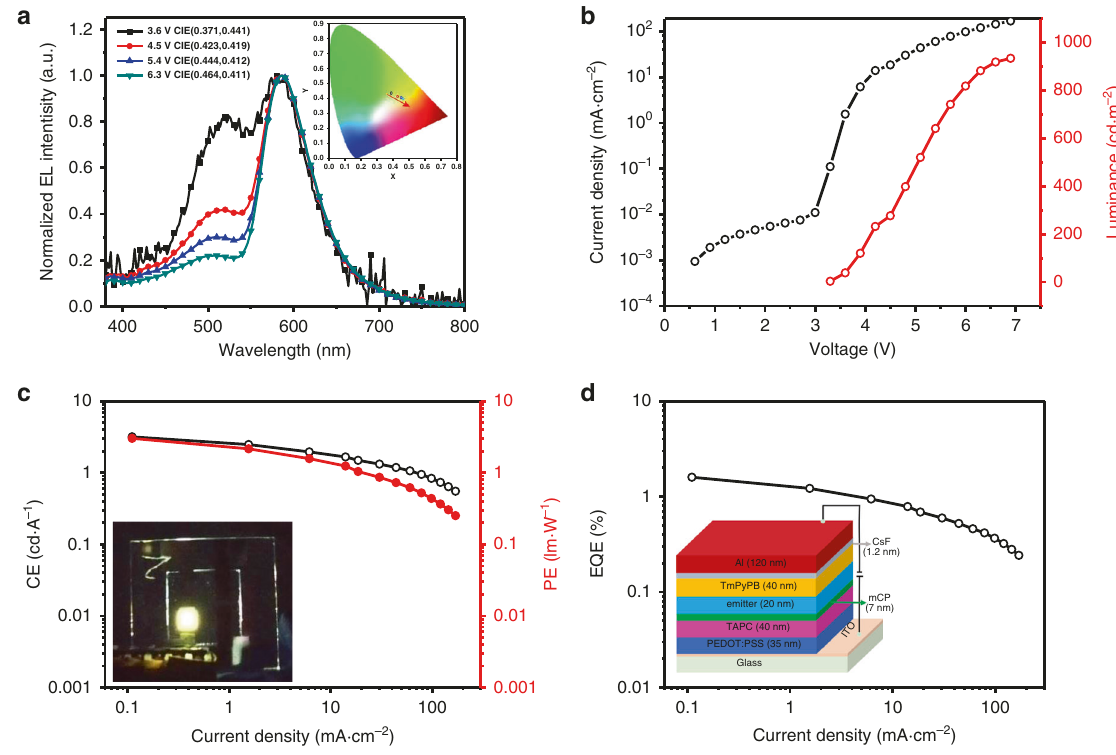
Fig. 4 The performance of device 1 based on nondoped rac-BINAP emitter. a The EL spectrum under different voltages and insertion of the corresponding CIE coordinates. b Current density/luminance as the function of voltage. c The CE/PE as the function of current density. Inset: The photograph of device 1 under electronic excitation. d The EQE as the function of current density and insertion of device con fi guration.